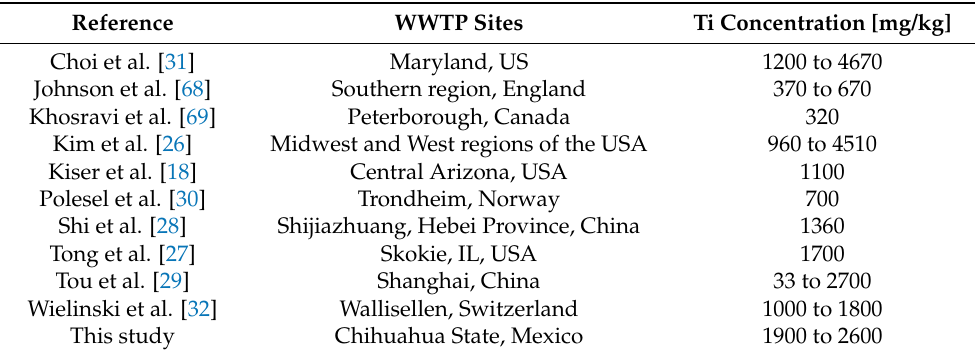
Table 2. Total Ti concentrations in WWTPs sludge from the literature, including this